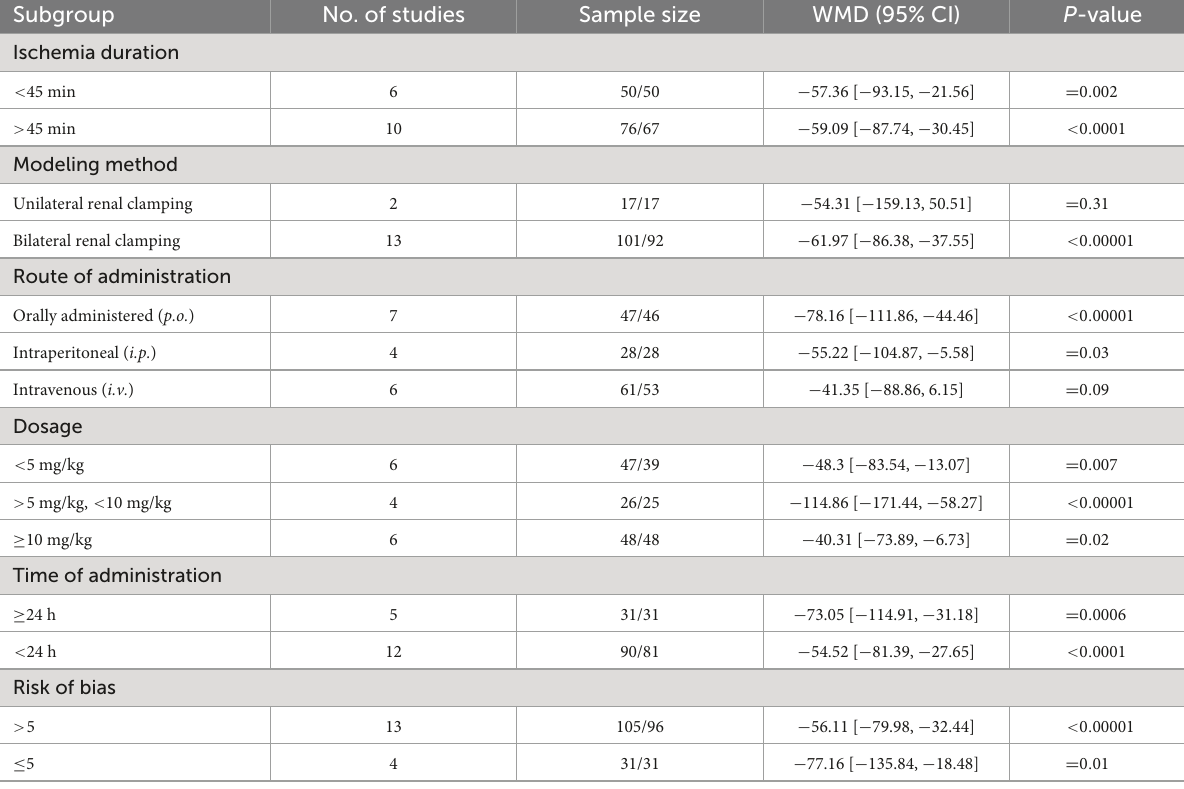
TABLE 3 Subgroup analysis of pooled estimates of SCr with different administration of RSV.